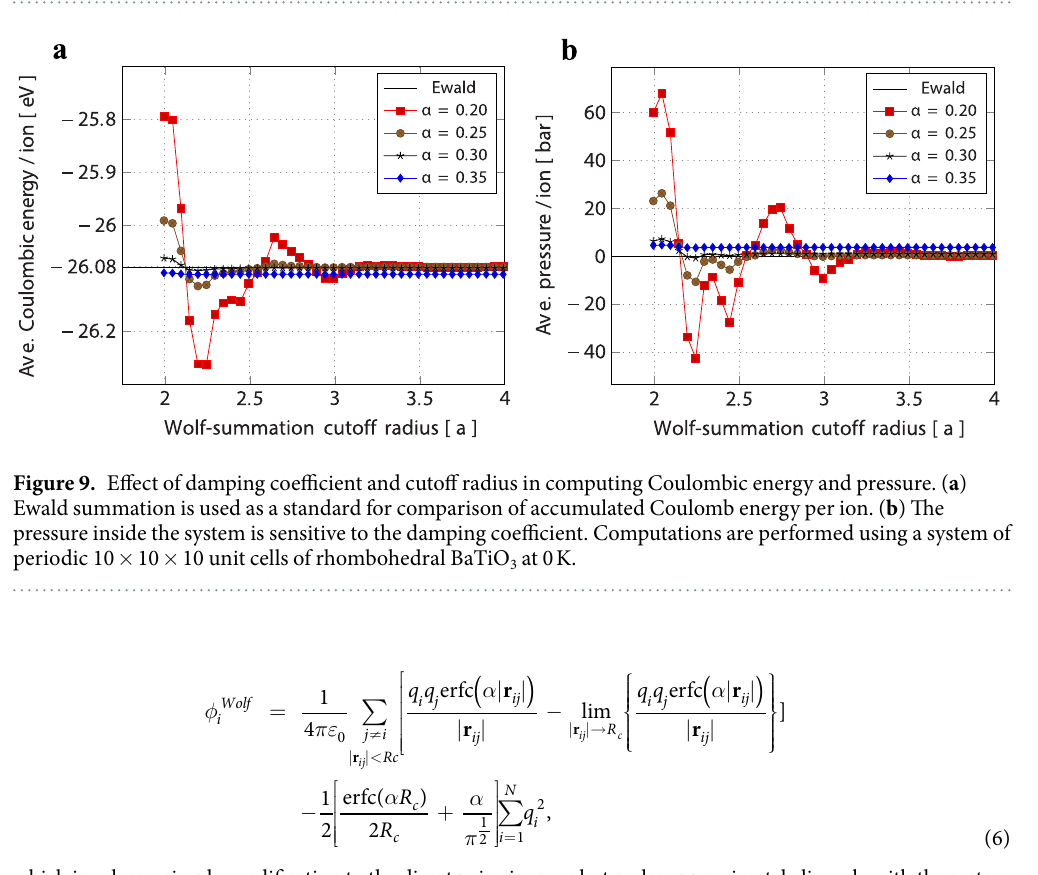
Figure 8. Schematic representation of the interactions in the core-shell model. Each atom is treated as having two components: a charged shell and a charged core connected by a nonlinear spring.